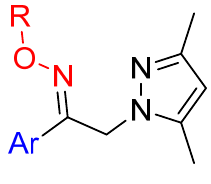
Figure 5. Chemical structure of the designed compounds ( 4a - 4f ; 5a - 5f ).